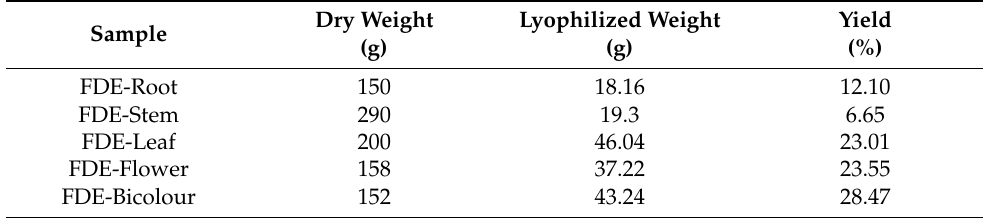
Table 1. Freeze-dried extract yields of P. peltatum